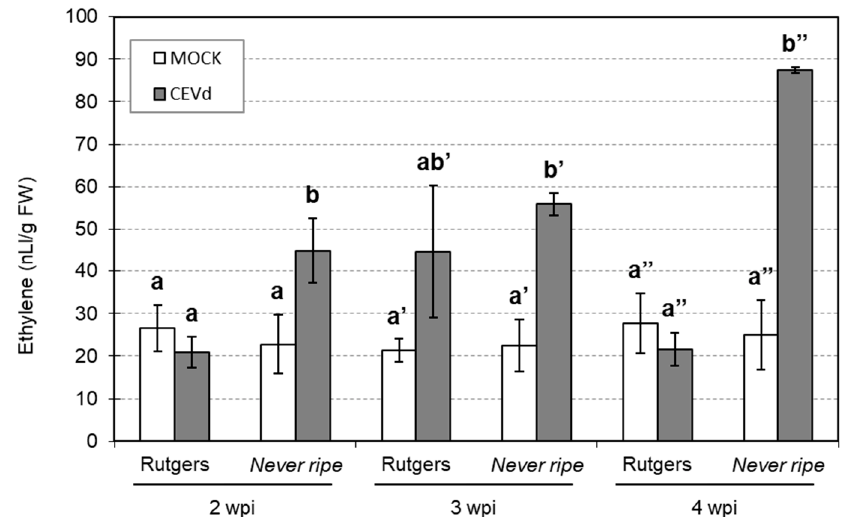
Figure 7. Ethylene emission levels in both mock and CEVd infected Rutgers and Nr tomato leaves at two, three, and four weeks post inoculation (wpi). Data correspond to the mean ± SD of at least two biological replicates. Results are shown from one representative experiment. Data were analyzed using a Mann–Whitney test and different letters indicate significant differences ( p < 0.05). Number of ( ’ ) indicates different weeks.